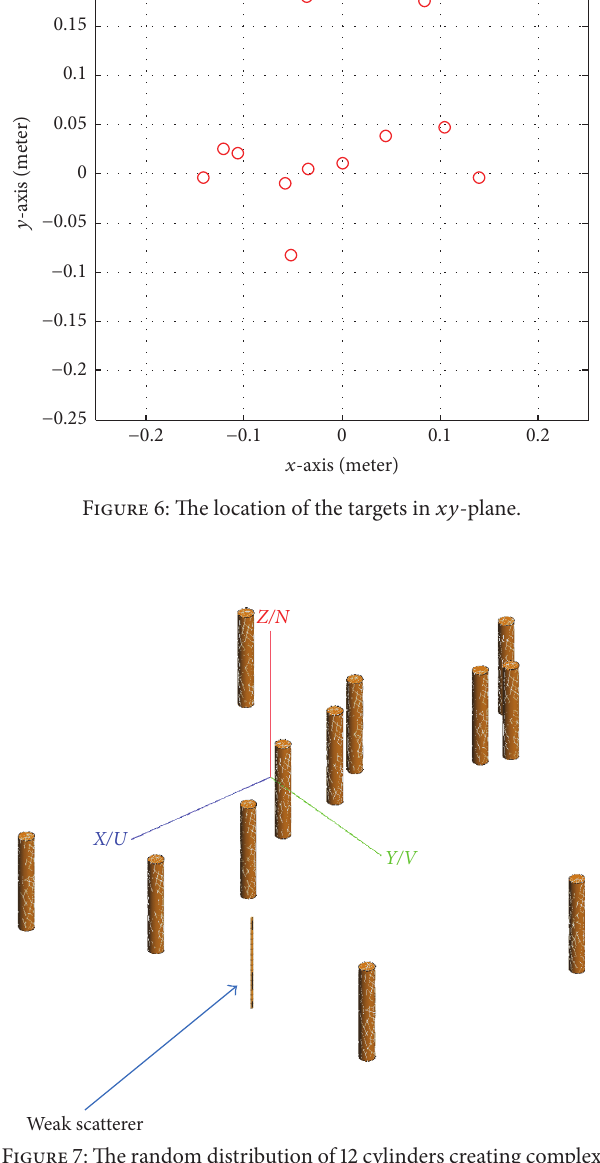
Figure 7: The random distribution of 12 cylinders creating complex target in 𝑥𝑦